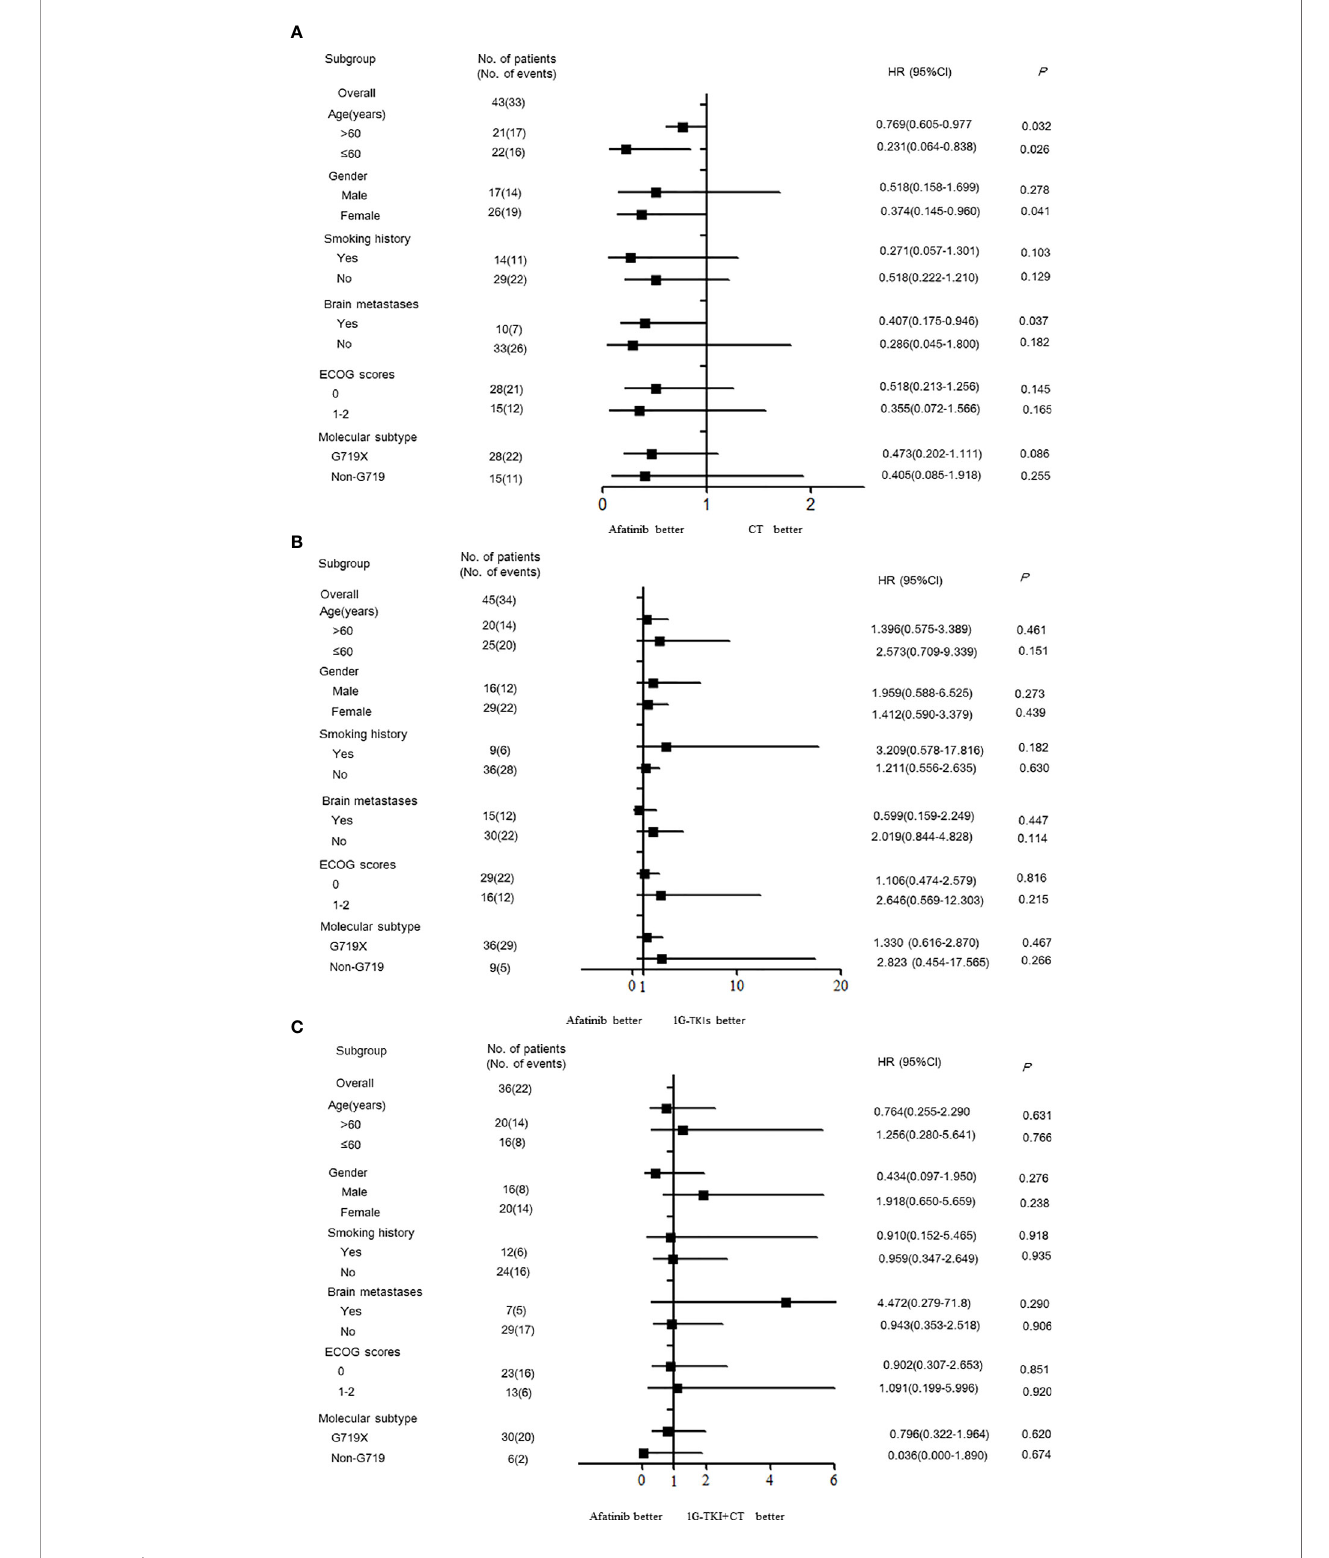
FIGURE 3 | Forest plots by the various demographics and disease characteristics. (A) afatinib vs. CT (B) afatinib vs. 1GTKI (C) afatinib vs. 1G TKI+CT. (CT, chemotherapy; 1G-TKI, fi rst-generation tyrosine kinase